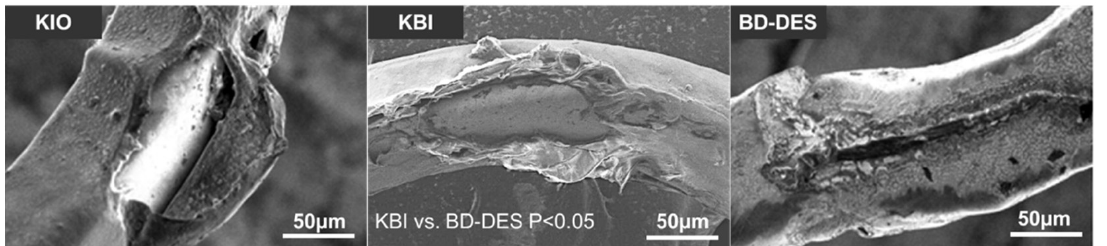
Table 2. SEM analysis of polymer coating damage ( n = 5).